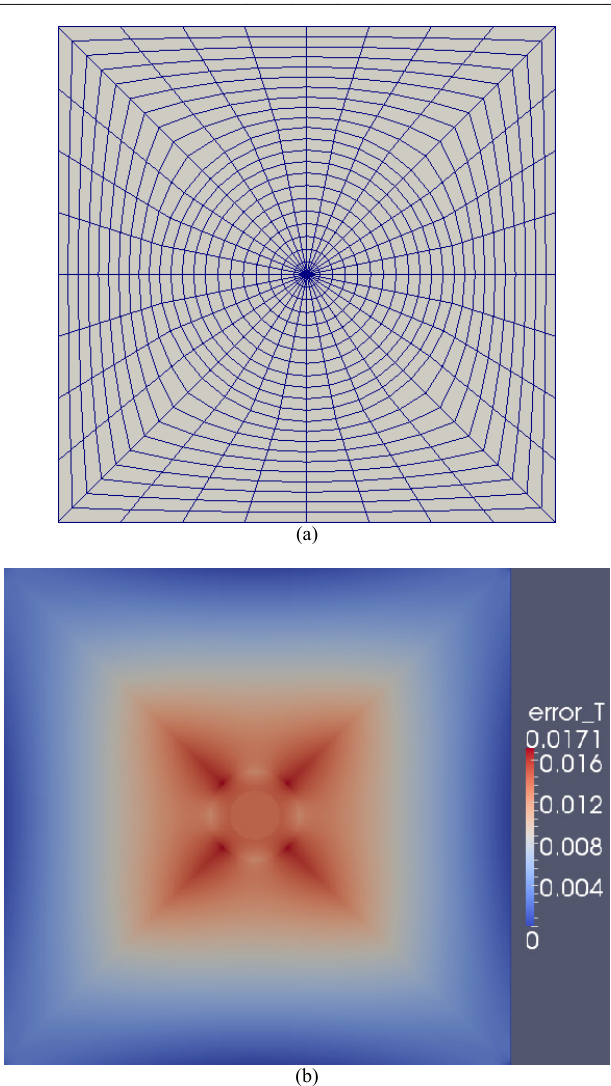
Fig. 6. Rectangular mesh topology (a) and the corresponding error (b) with N=180224.